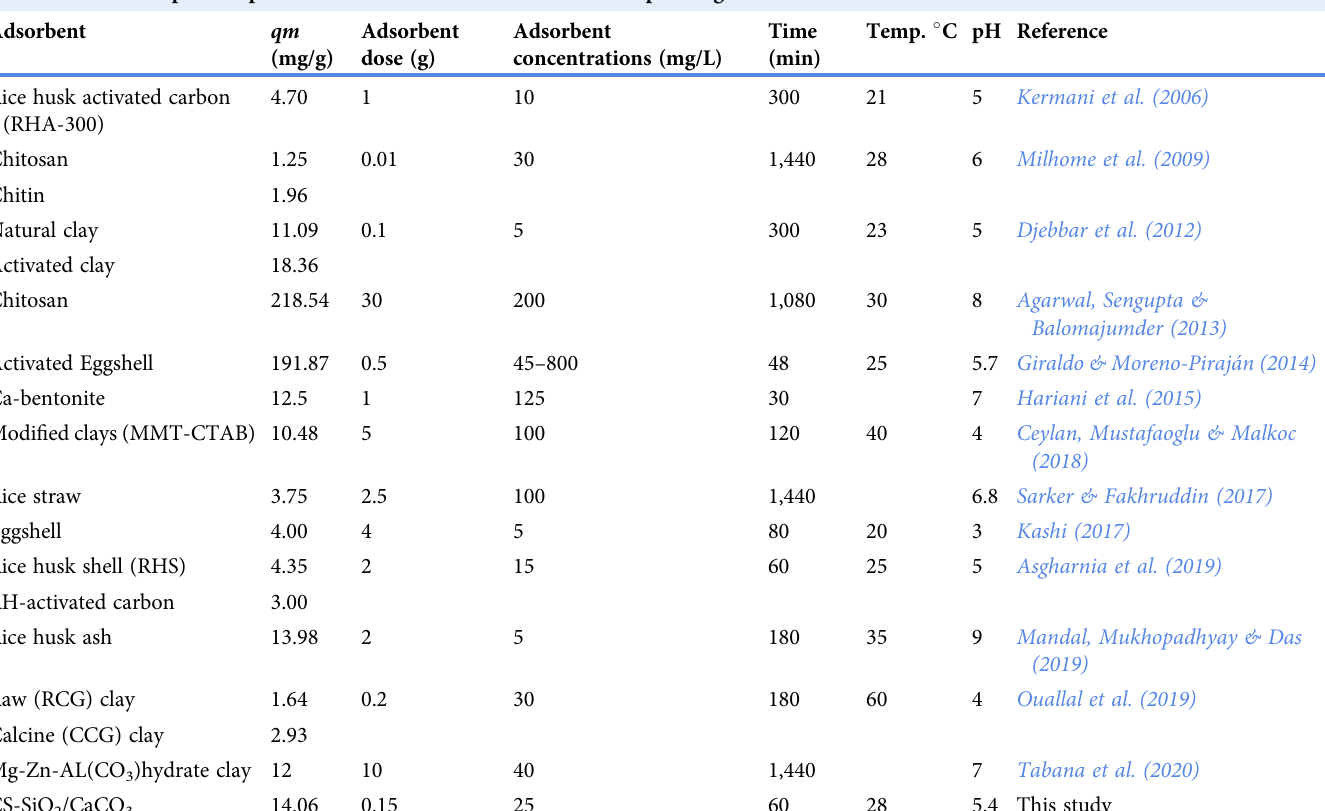
Table 3 The adsorption capacities of different adsorbents and corresponding reaction conditions.